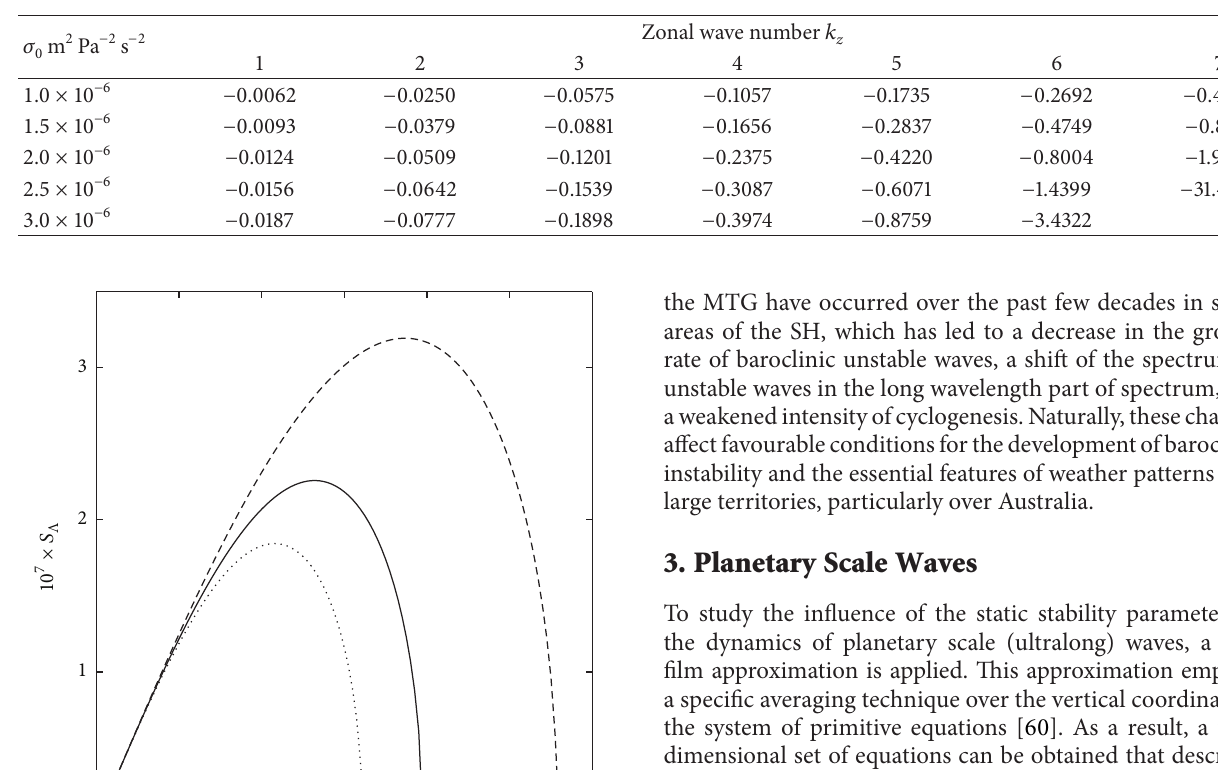
Table 2: Relative sensitivity 𝑆 𝑅 𝜎 as a function of zonal wavenumber 𝑘 𝑧 for different values of static stability parameter 𝜎 0 .